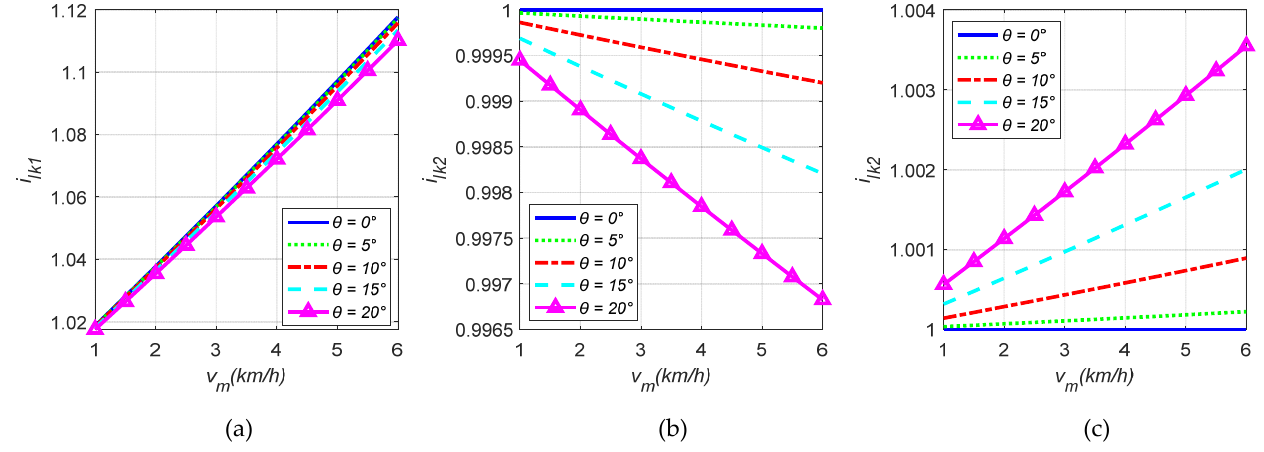
Figure 6. Effects of v m and θ on 𝑖 (cid:3039)(cid:3038)(cid:2869) and 𝑖 (cid:3039)(cid:3038)(cid:2870) : ( a ) effects of v m and θ on 𝑖 (cid:3039)(cid:3038)(cid:2869) ; ( b ) effects of v m and θ on 𝑖 (cid:3039)(cid:3038)(cid:2870) in up-grinding; ( c ) effects of v m and θ on 𝑖 (cid:3039)(cid:3038)(cid:2870) in down-grinding.